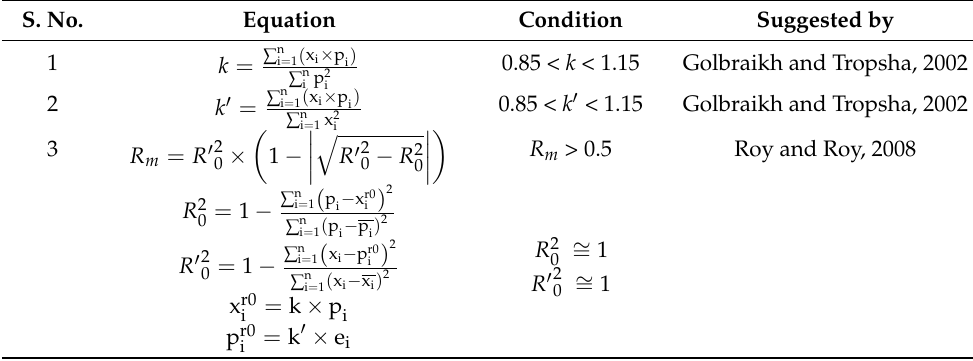
Table 6. External validation